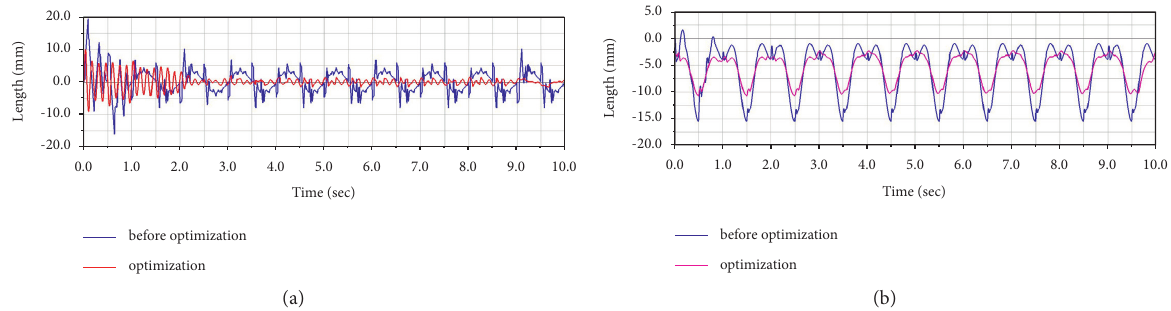
Figure 5: Posture angle of body. (a) The roll angle of the body during the movement of the robot. (b) The pitch angle of the body during the movement of the robot.